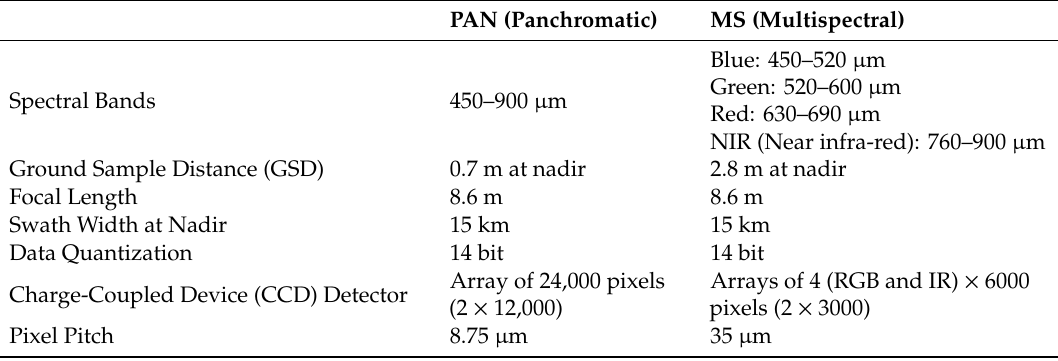
Figure 1. Configuration of KOMPSAT-3 Advanced Earth Imaging Sensor System (AEISS) sensor for ( a ) camera rear view and ( b ) Charge-Coupled Device (CCD) array [13]. Table 1. KOMPSAT-3 specifications.